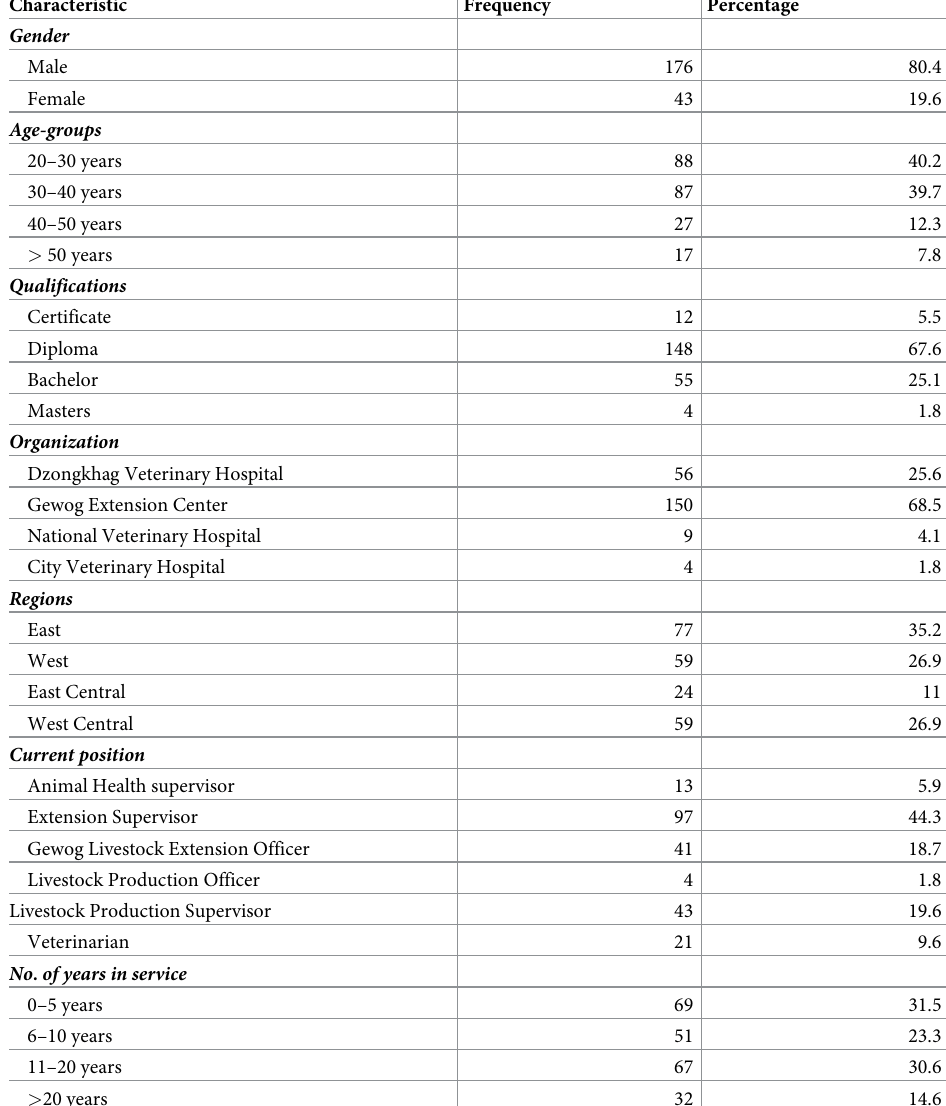
Table 1. Demographic characteristics of the